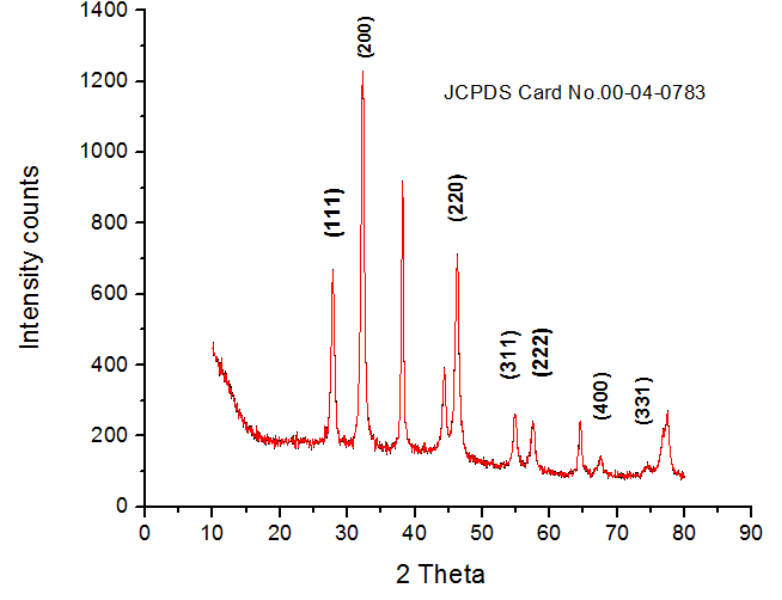
Figure 4. X-ray diffraction pattern of biogenic silver nanoparticles.